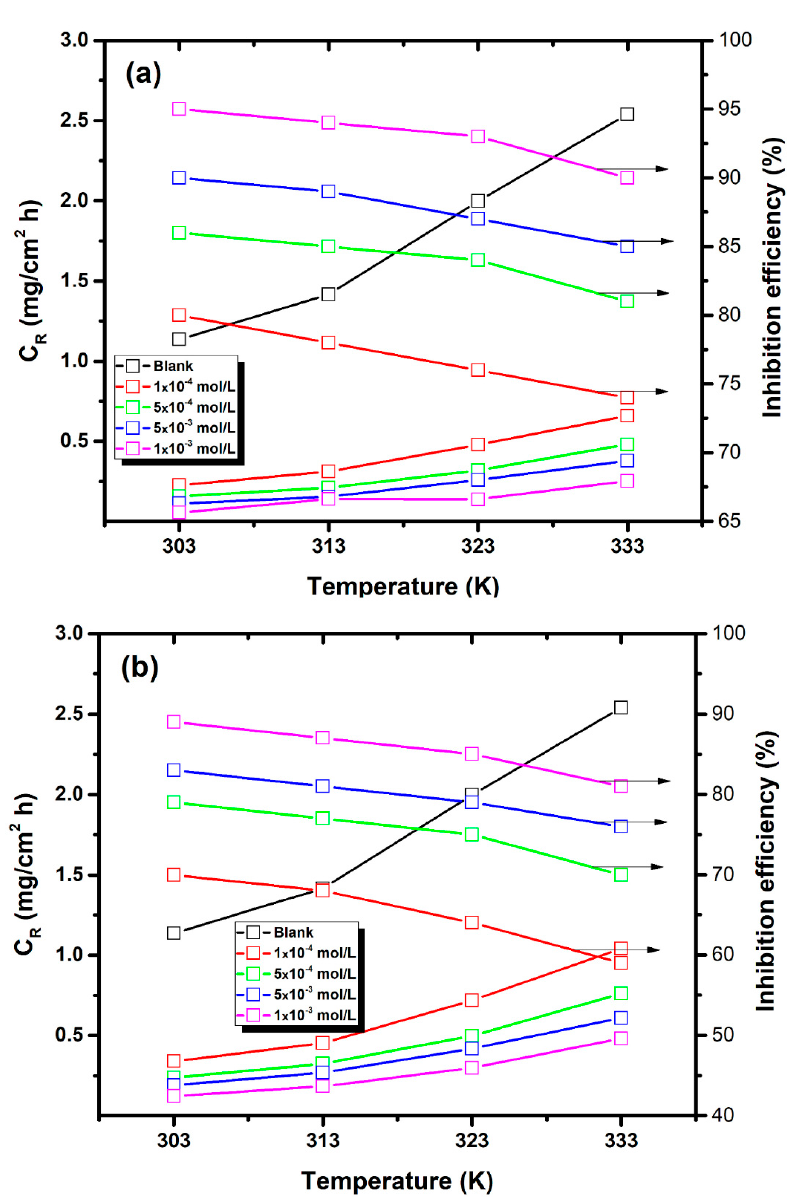
Figure 2. The e ff ect of temperature toward the corrosion rate and inhibition e ffi ciency for MS without Figure 2. The effect of temperature toward the corrosion rate and inhibition efficiency for MS and with ( a ) Q1 and ( b ) without and with ( a ) Q1 and ( b ) Q2.